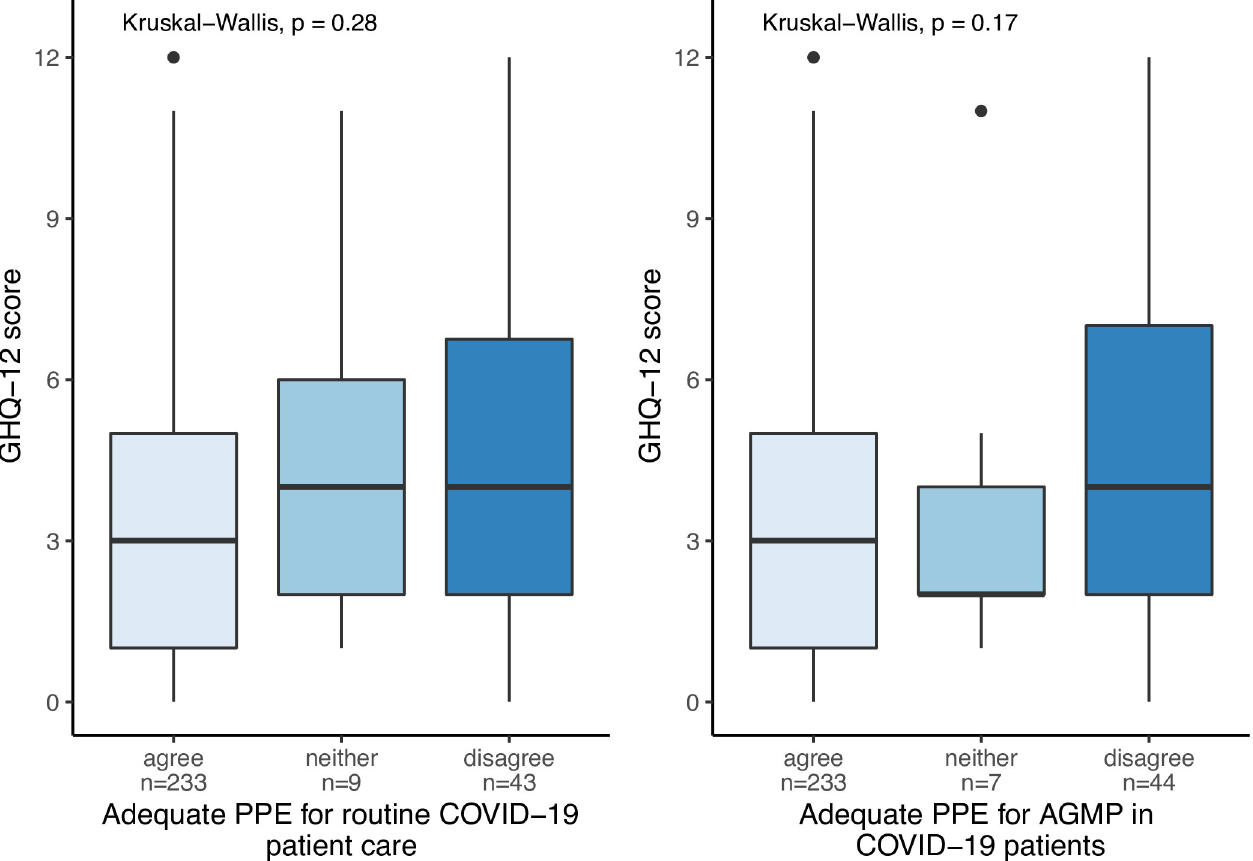
Fig 5. GHQ-12 scores relative to PPE availability. GHQ-12 scores relative to (A) access to PPE for routine patient care and (B) access to PPE for AGMP. Participants were subdivided into “disagree” (1–3 points on a 7-point Likert scale), “neutral” (4 points) and “agree” (5–7 points).